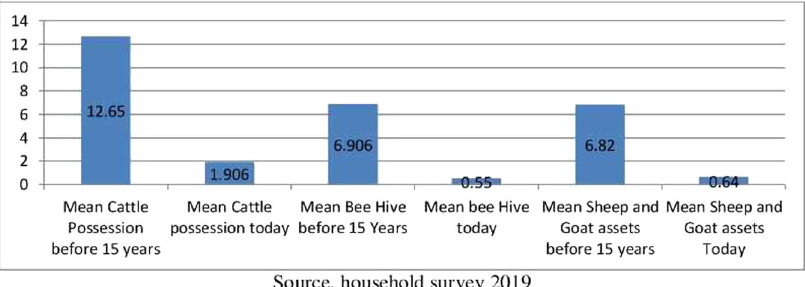
Fig. 3 Comparison of current mean landholding size of sample households before 15 years. Figure also compared the current mean landholding size of surveyed households with the last 15 years. The land size held by farming households was getting scanty and scanty by the illicit horizontal expansion of